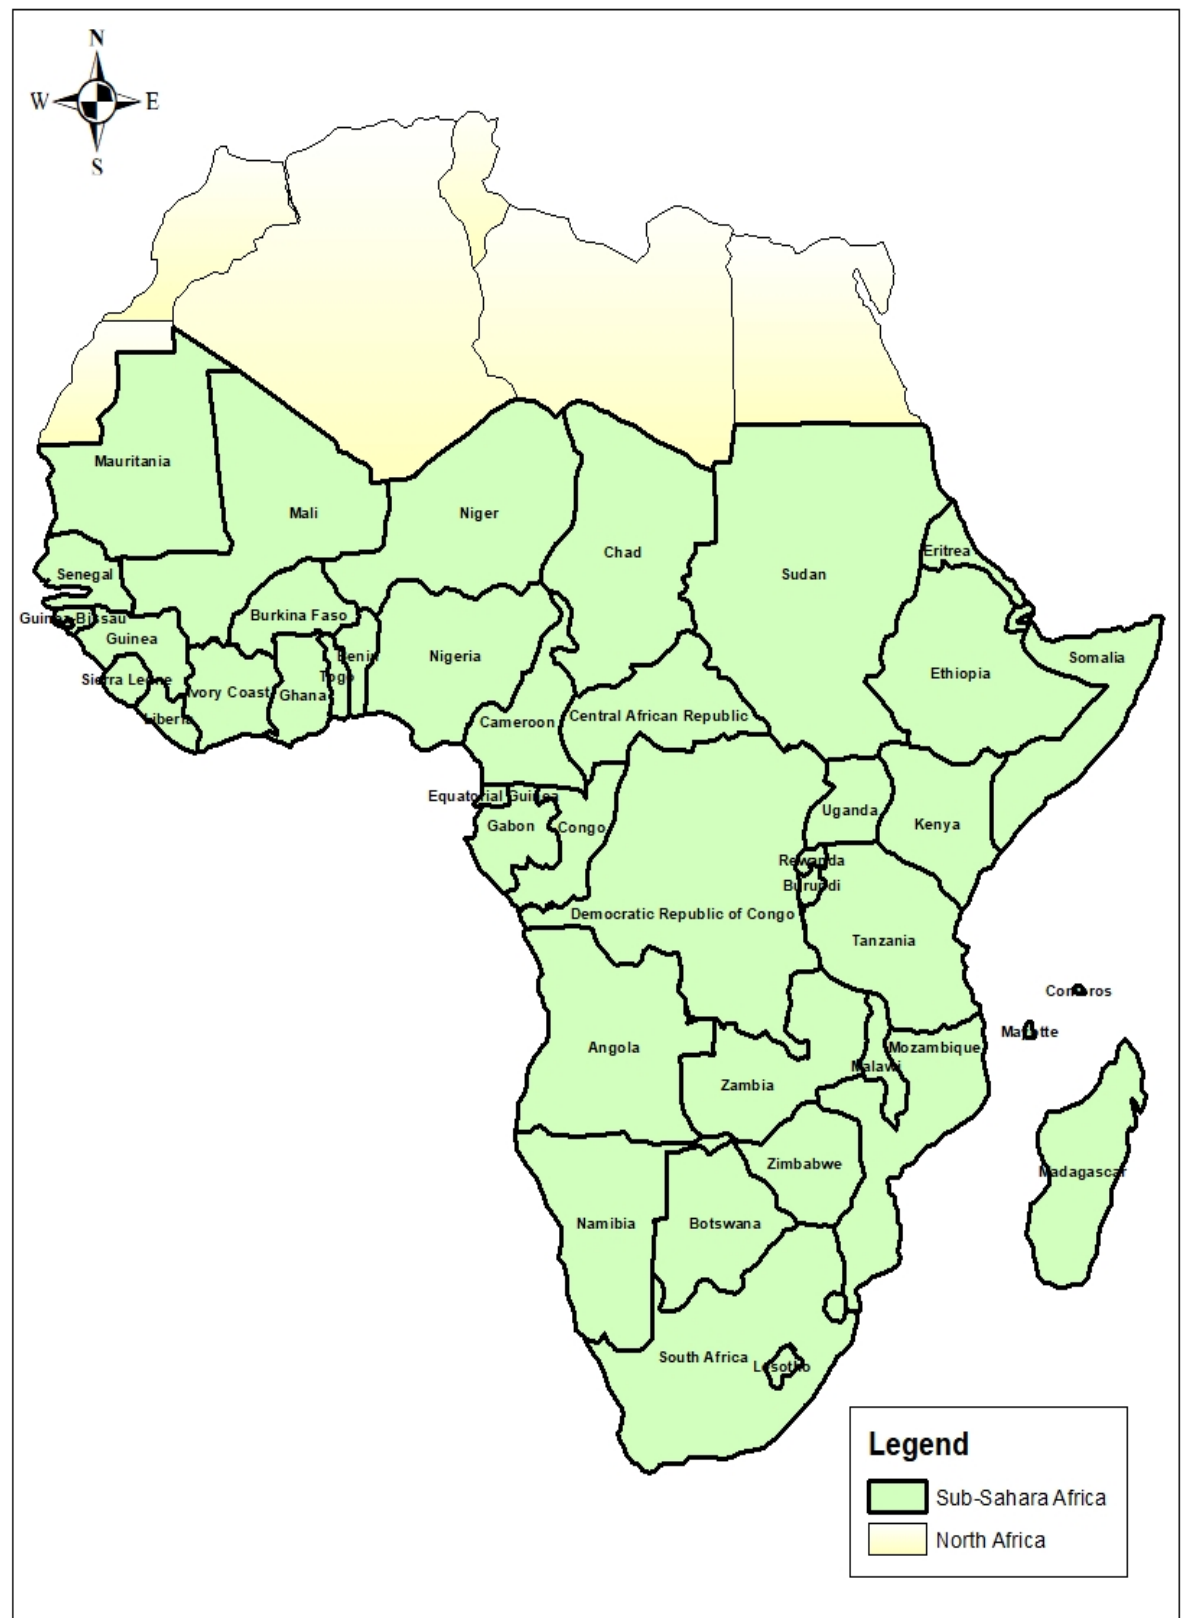
Figure 2. SSA countries.